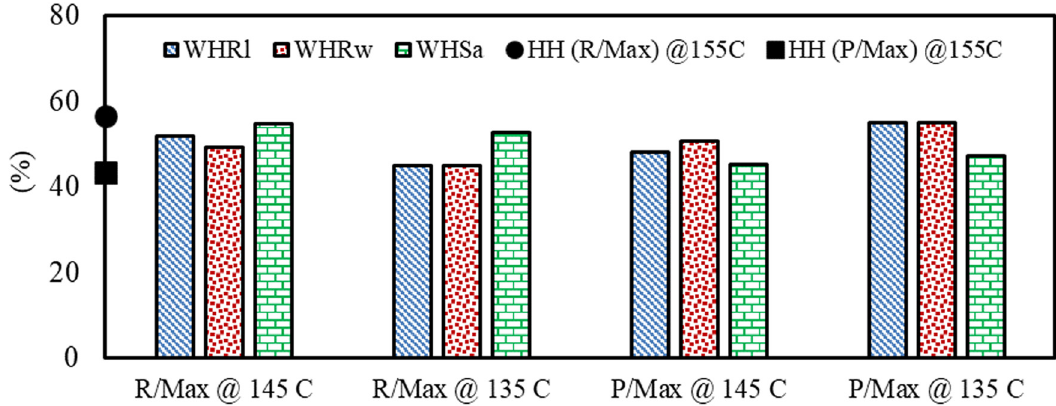
Figure 14: Final percentages of recovered and permanent strain at the termination of the fi rst cycle of MSCR.